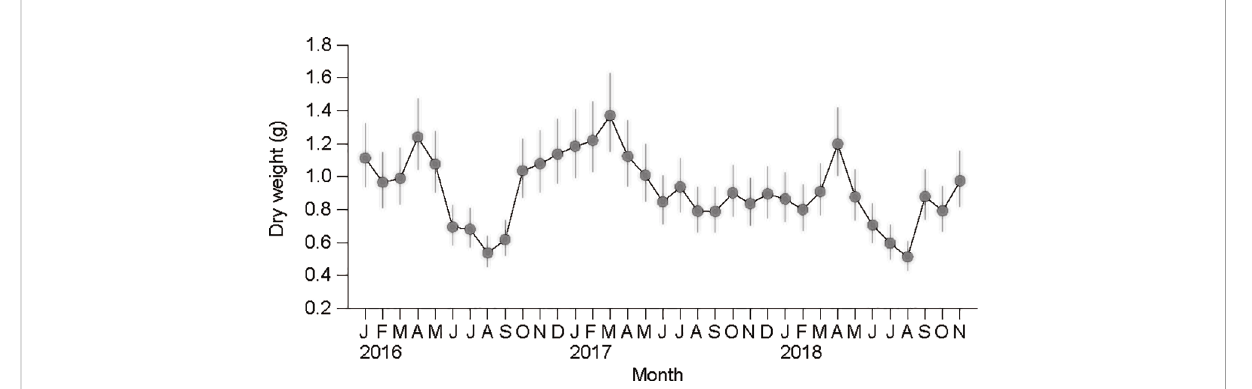
FIGURE 6 Seasonal variation in dry- fl esh weight in a standard individual with a shell length of 34.3 mm recorded from January 2016 to November 2018. The vertical bars represent 95% con fi dence